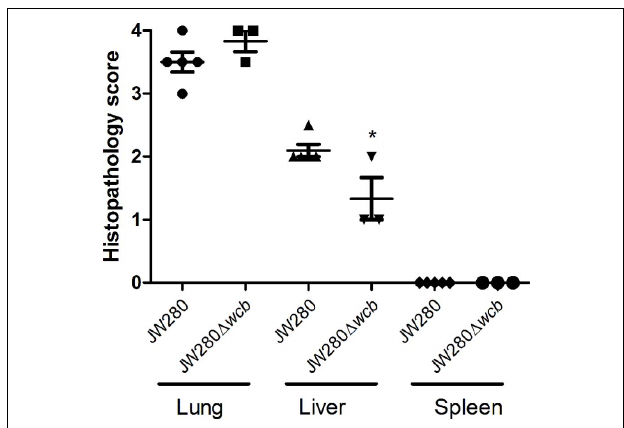
FIGURE 4 | Histopathological scoring of SKH1 infected tissue. Lung, liver, and spleen from SKH1 mice infected i.n. with JW280 (10 4 CFU) or JW280 (cid:2) wcb (10 6 CFU) were fixed, stained with H&E, and scored in a blind study for varying degrees of pathology.The scoring system was defined as: 0 = within normal limits, 1 = minimal, 2 = mild, 3 = moderate, 4 = severe. Individual data points, the mean, and standard deviation are plotted, and statistically significant variation from JW280-infected tissue scoring is indicated by asterisks (* p < 0.05).